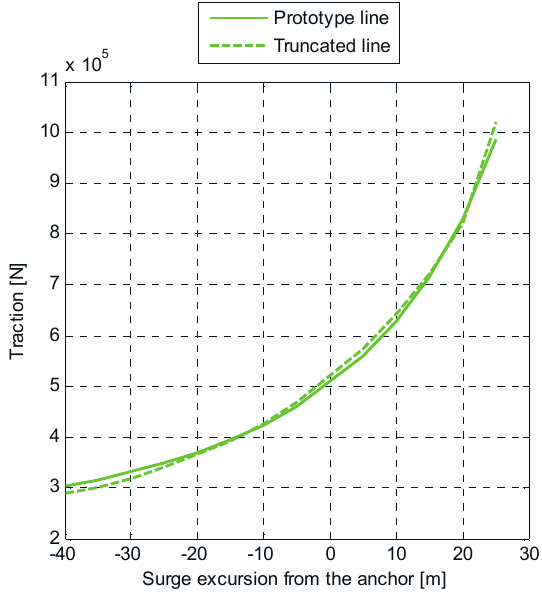
Figure 11. Traction mooring line response.